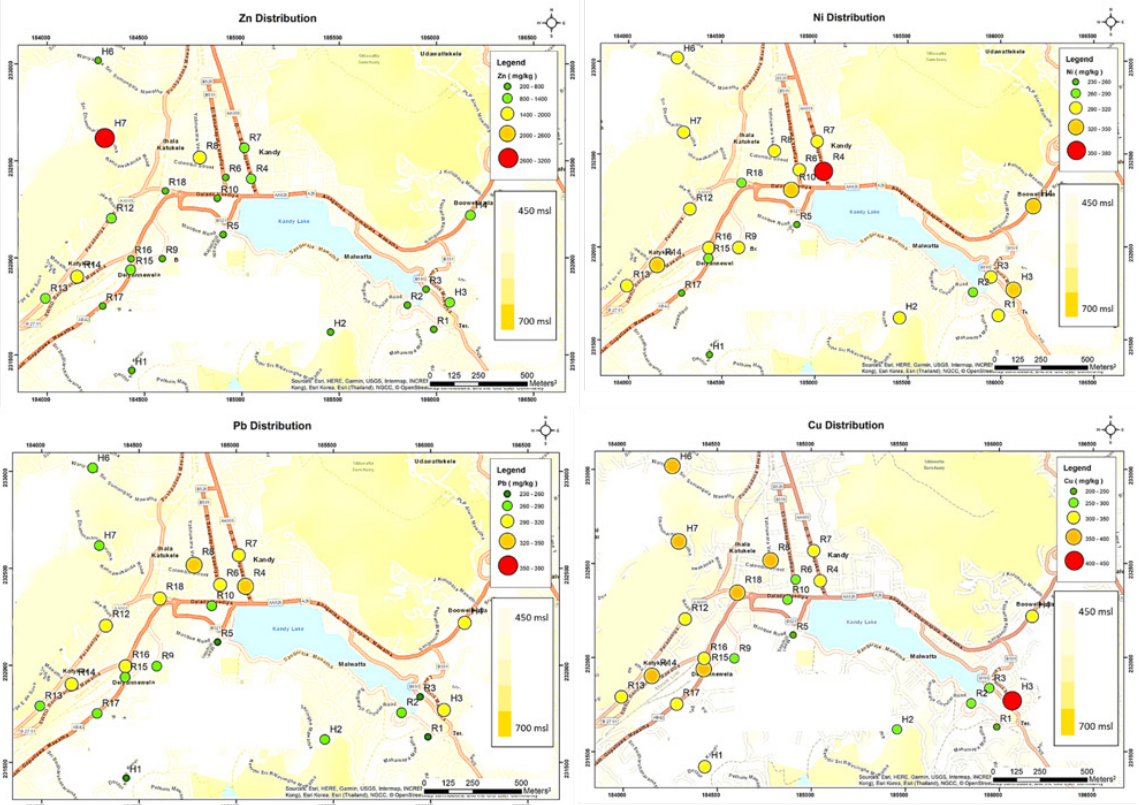
Figure 3: Maps showing the distribution of heavy metals (Zn, Ni, Pb and Cu) in the study area.